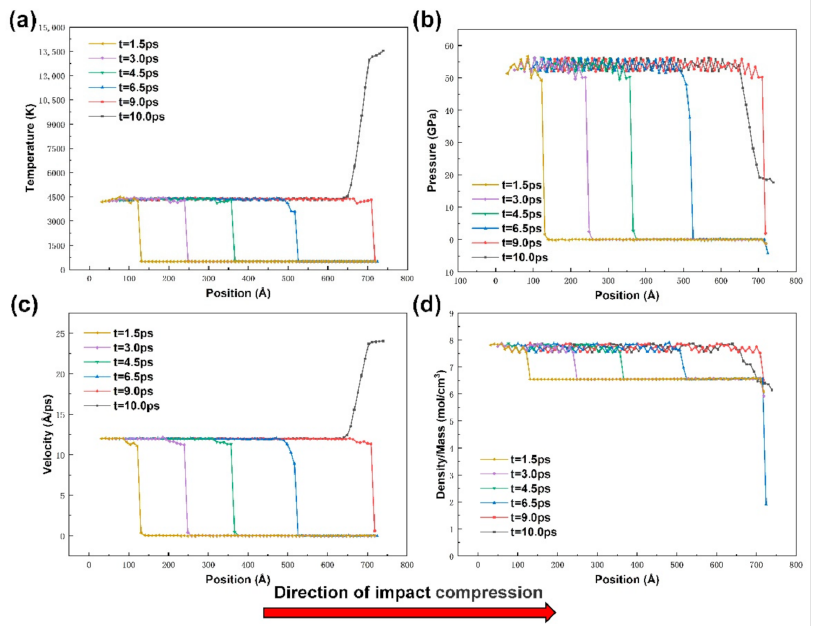
Figure 7. Variation curve of average value of each atom in all physical quantities during impact compression of non-porous samples: ( a ) temperature; ( b ) pressure; ( c ) velocity; ( d ) ratio of density to